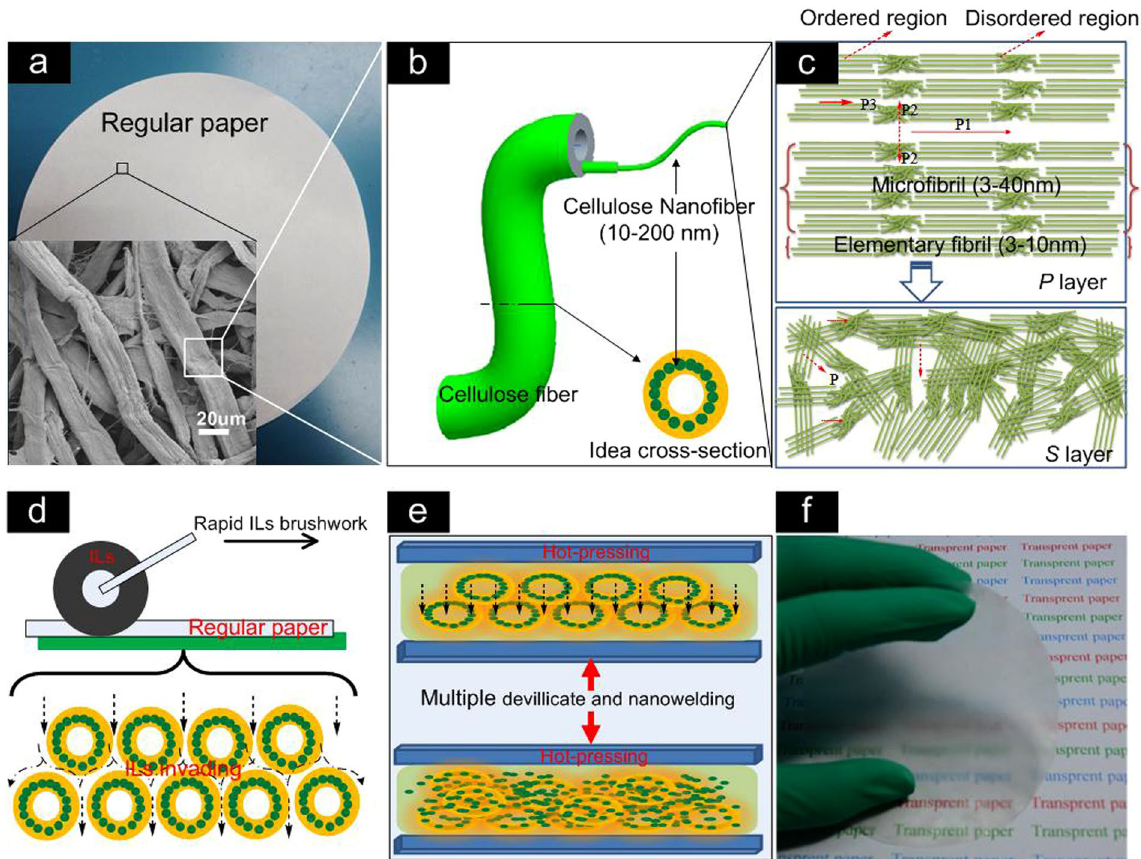
Figure 1. Schematic of the rapid ILs-polishing process for directly fabricating the nanostructured transparent paper from a regular paper. ( a ) Regular paper. The insert in the bottom left corner is a SEM image of the regular paper. ( b ) The ideal structure of single cellulose fiber. The insert in the bottom right corner is a magnified idealdiagram of cellulose nanofibers distributing along the cross section of a single cellulose fiber. ( c ) The various invading pathways of ILs in the P, L layers on the cell wall. The S Layer indicates the invading channel for ILs in disordered S region, while the P1 , P2 , P3 indicates respectively the invading channel for ILs exiting in the ordered region of gaps microfibrils, amorphous and elementary fibrils. ( d ) The invading models of ILs in fibrous cellulose matrix under a hot pressing process. ( e ) Formation of cellulose nanofibers and its nanowelding process. ( f ) Digital picture of the nanostructured